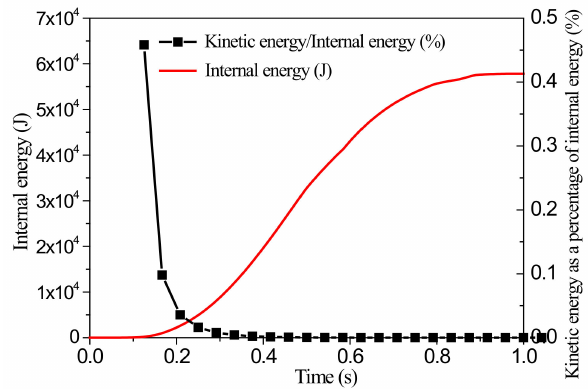
Figure 9. Variations of internal energy and of ratio of kinetic energy to internal energy with time.